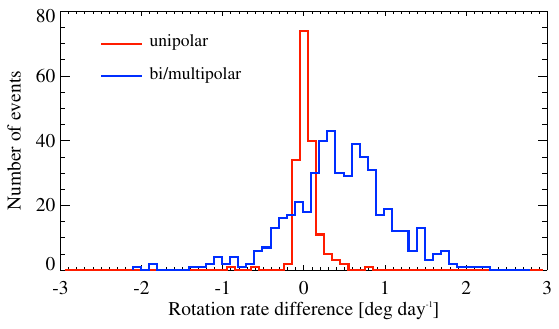
− ω m difference for unipolar sid sid